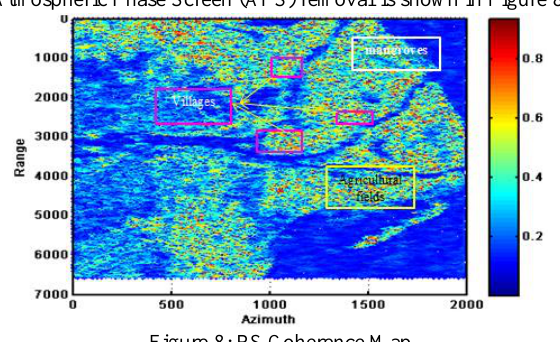
Figure 8: PS Coherence